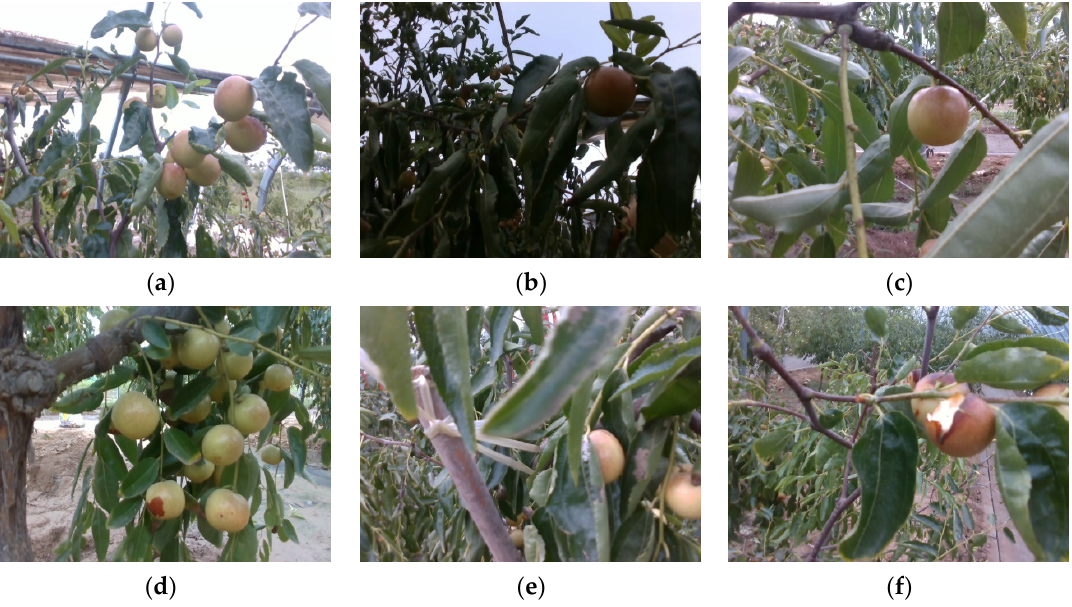
Figure 1. Winter jujubes in different scenes. ( a ) Bright light; ( b ) Dim light; ( c ) Single target; ( d ) Mul- tiple targets; ( e ) Behind branch and leaves; ( f ) Broken